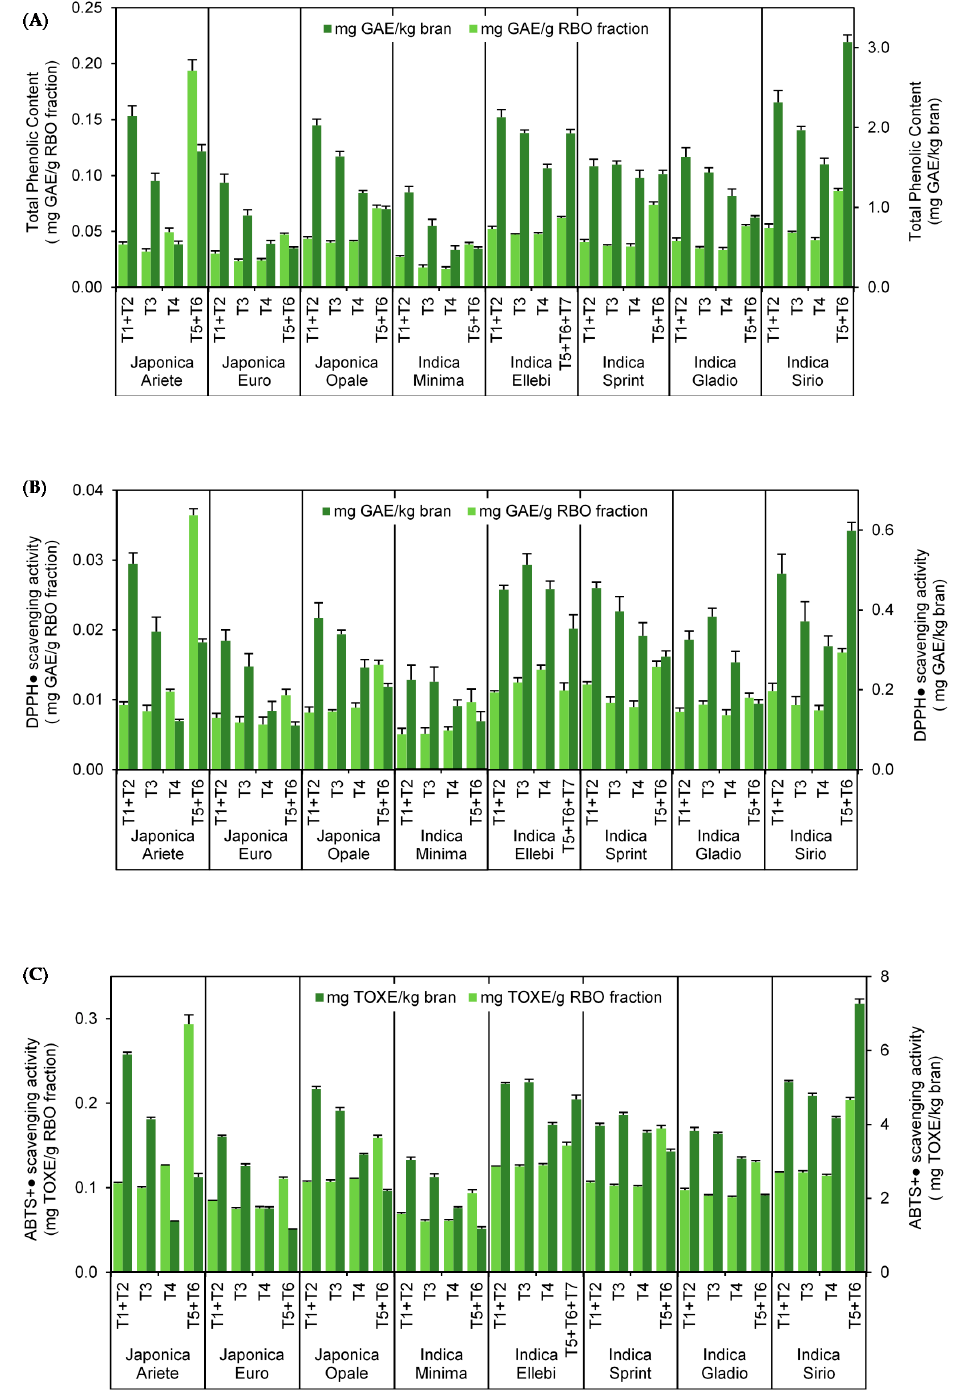
Figure 6. Antioxidant activity of MeOH-RBO fractions: ( A ) total phenolic content, ( B ) DPPH radical scavenging, and ( C ) ABTS radical cation scavenging activity. The DPPH radical scavenging activity of MeOH-RBO fractions varied from 0.0051 mg of GAE/g of RBO fraction (Indica Minima, T1 + T2) to 0.0364 (Japonica Ariete, T5 + T6) and from 0.111 mg of GAE/kg of bran (Japonica Euro, T5 + T6) to 0.598 (Indica Sirio, T5 + T6) (Figure 6B). The ABTS ● + scavenging activities of MeOH-RBO fractions ranged from